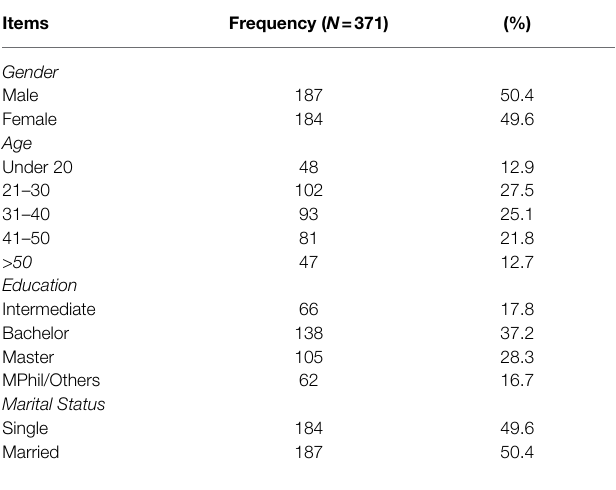
TABLE 1 | Demographic characteristics.